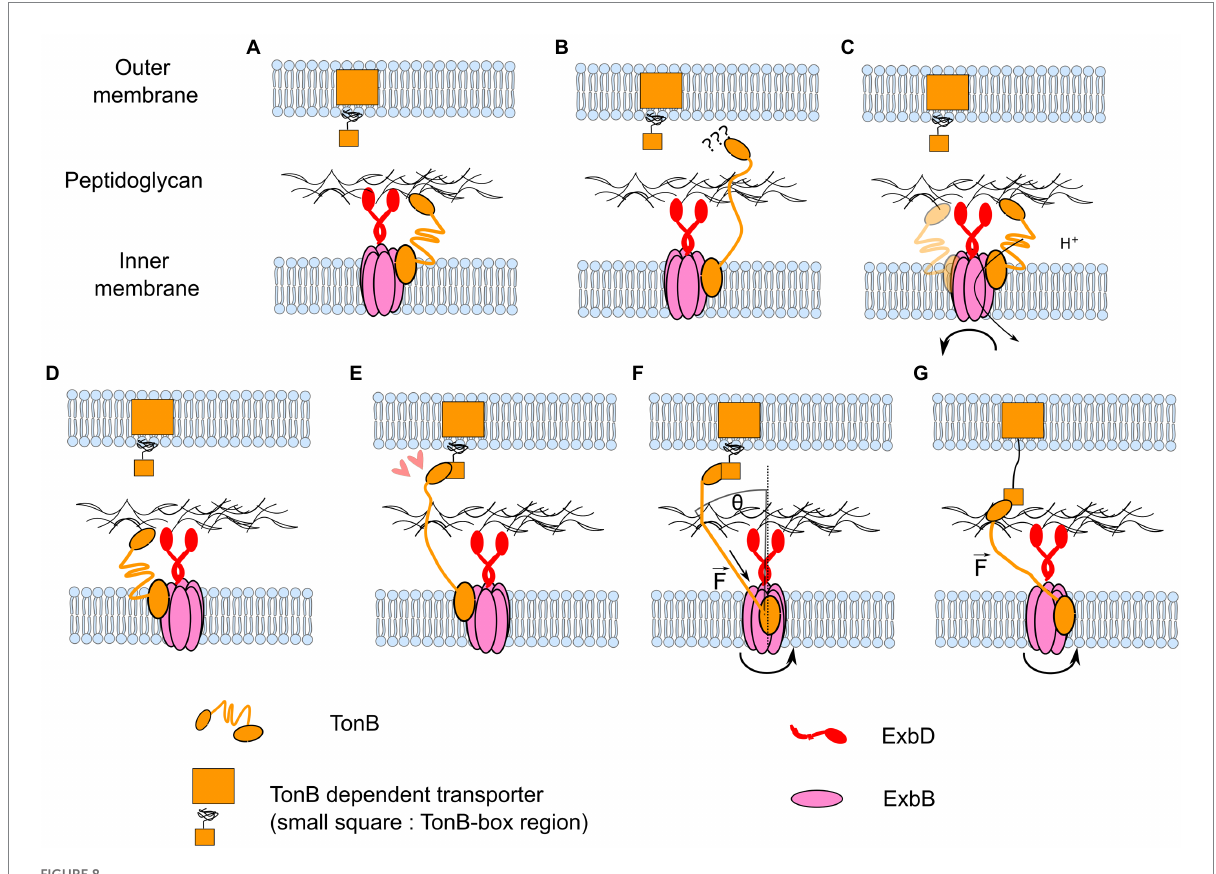
FIGURE 8 Model for how rotary motion of ExbBD could accomplish the functions of seeking TonB-dependent transporters and pulling on them. (A–C) Coupled with the flexibility of TonB, the rotation of ExbBD would allow the repositioning of TonB when it is retracted into the IM periplasmic space. (D–E) When it is properly positioned, TonB can bind to the TonB-dependent transporter. (F) Rotation of ExbBD pulls on the N-terminus of TonB. The maximum force applied to TonB depends on the angle θ and the number of ions per turn N r . (G) A sufficiently high force partially unfolds the TBDT and allows the import of extracellular